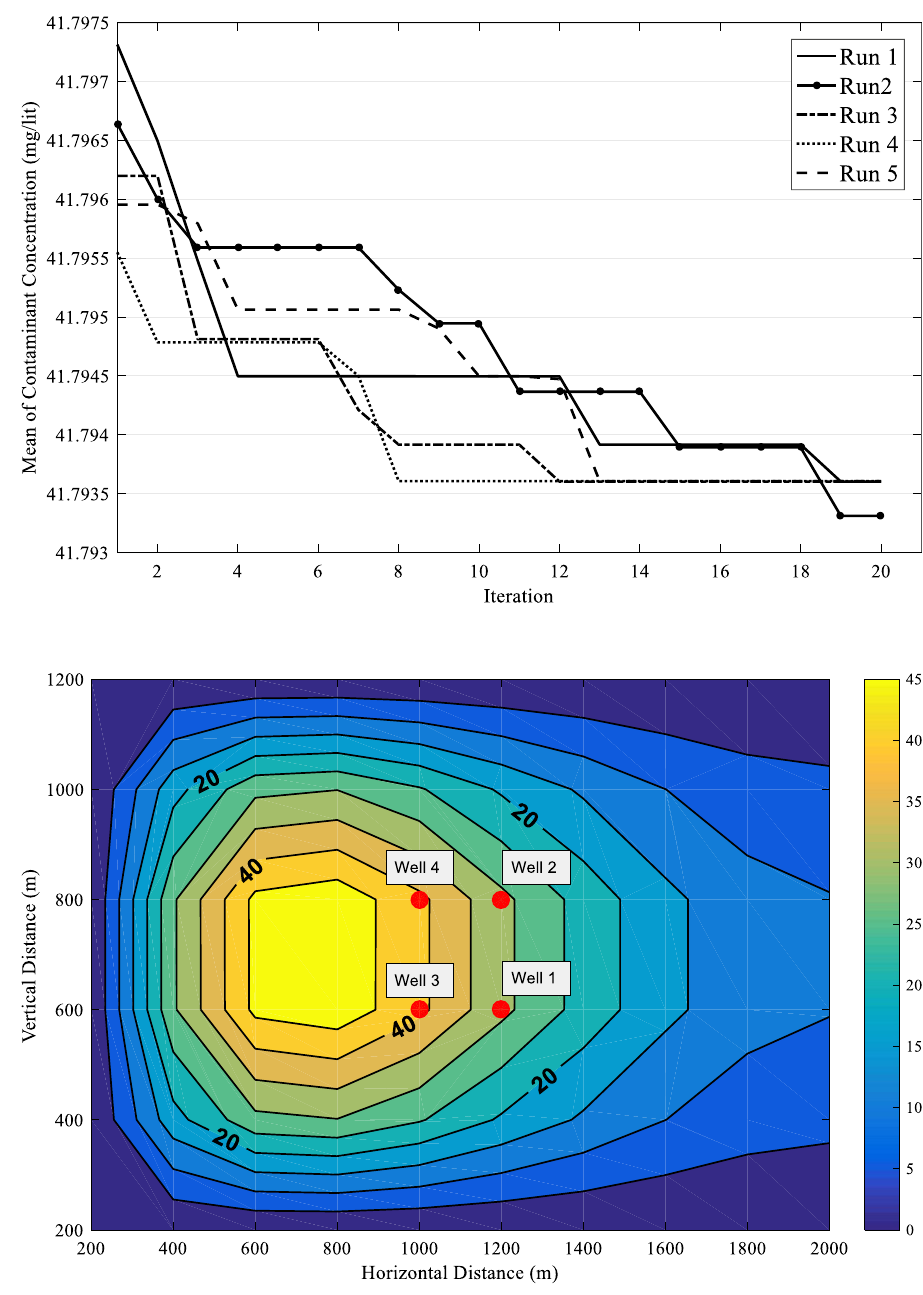
Fig. 6 The convergence trend of